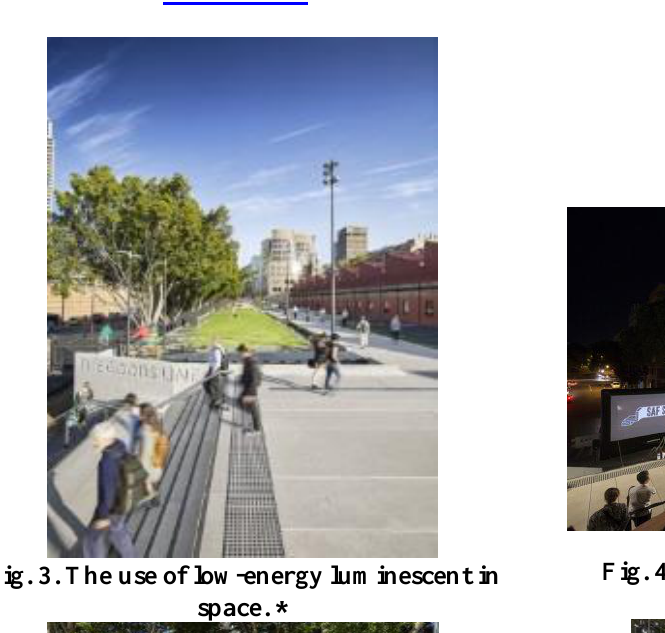
Fig. 1. Providing a yard for gathering and wi- Fig. 2. Children's playgrounds and exercise fi https://www.outdoordesign.com.au/landscape- furniture. https://www.aspect- supplies-hard/street-furniture/the-goods- studios.com/project/the-goods-line/ * line/6768.htm *